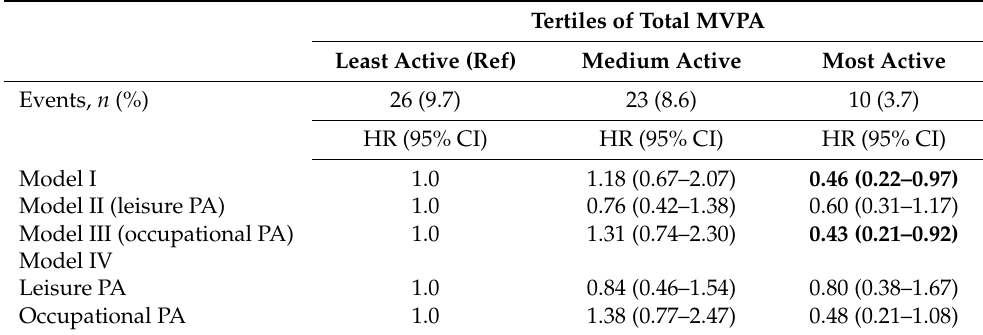
Table 3. Cox proportional hazards for device-measured moderate-to-vigorous physical